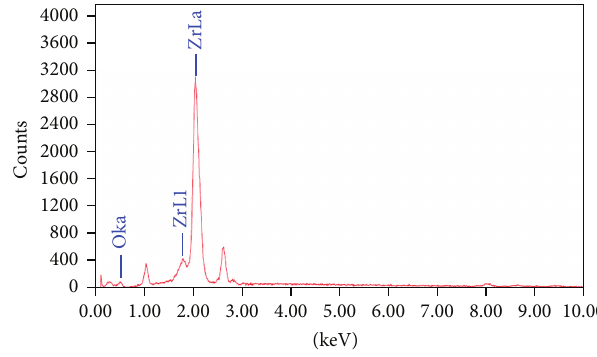
Figure 3: EDAX spectra of ZrO 2 of NPs calcinated at 400 ∘ C.